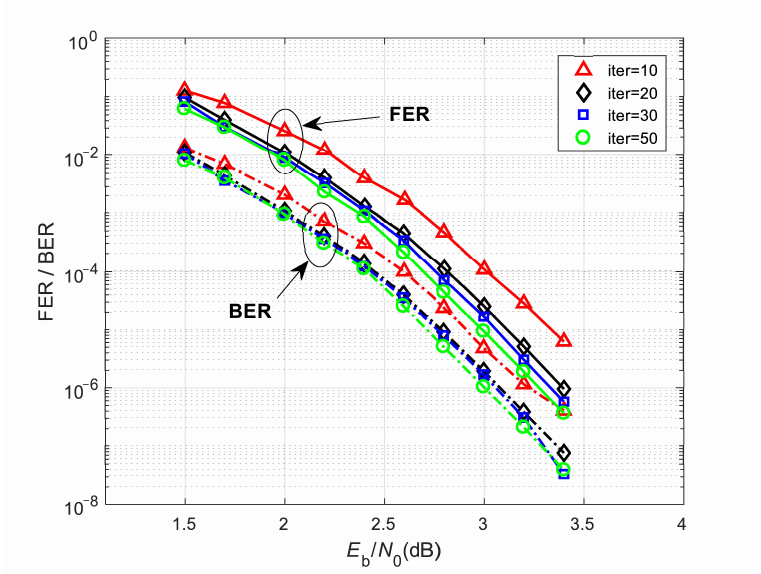
Figure 10. Performance of the (2, 4)- regular NB-LDPC code under different number of